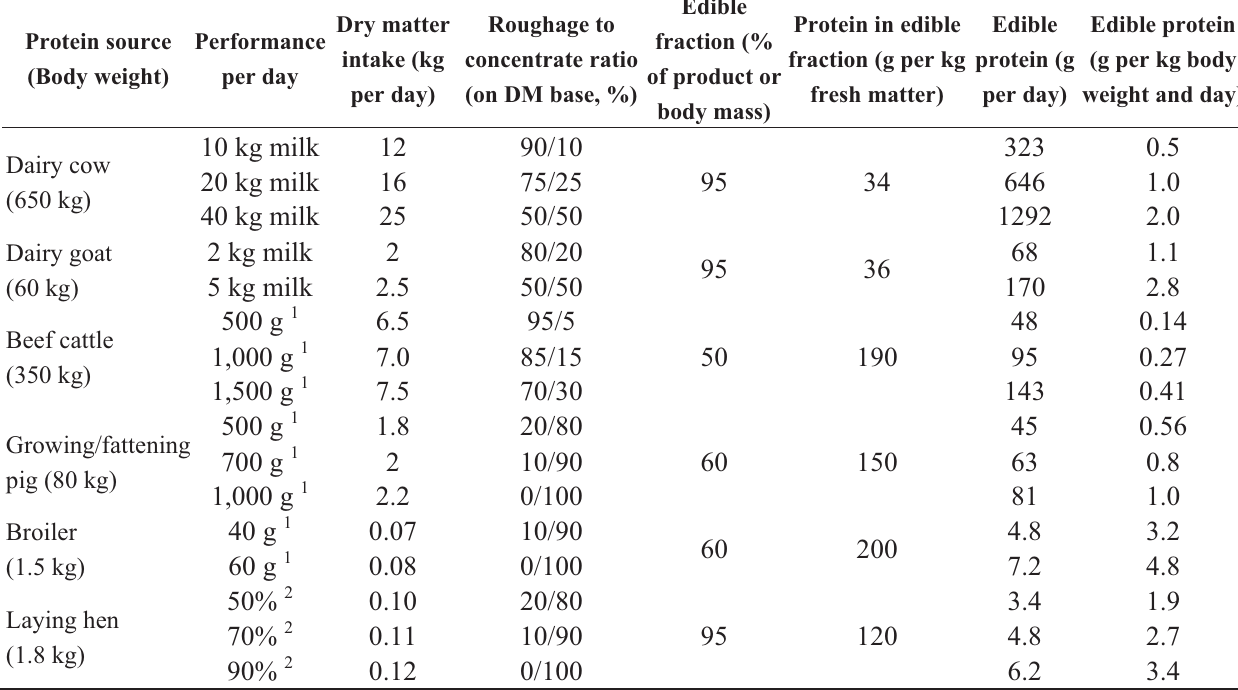
Table 7. Influence of animal species, categories and performances on yield of edible protein